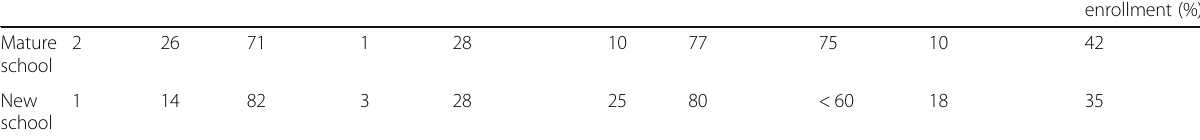
Demographic data is for the 2013 – 2014 school year and student performance data is for the year prior to joining PERC. “ College Ready ” refers to NYC DOE standards